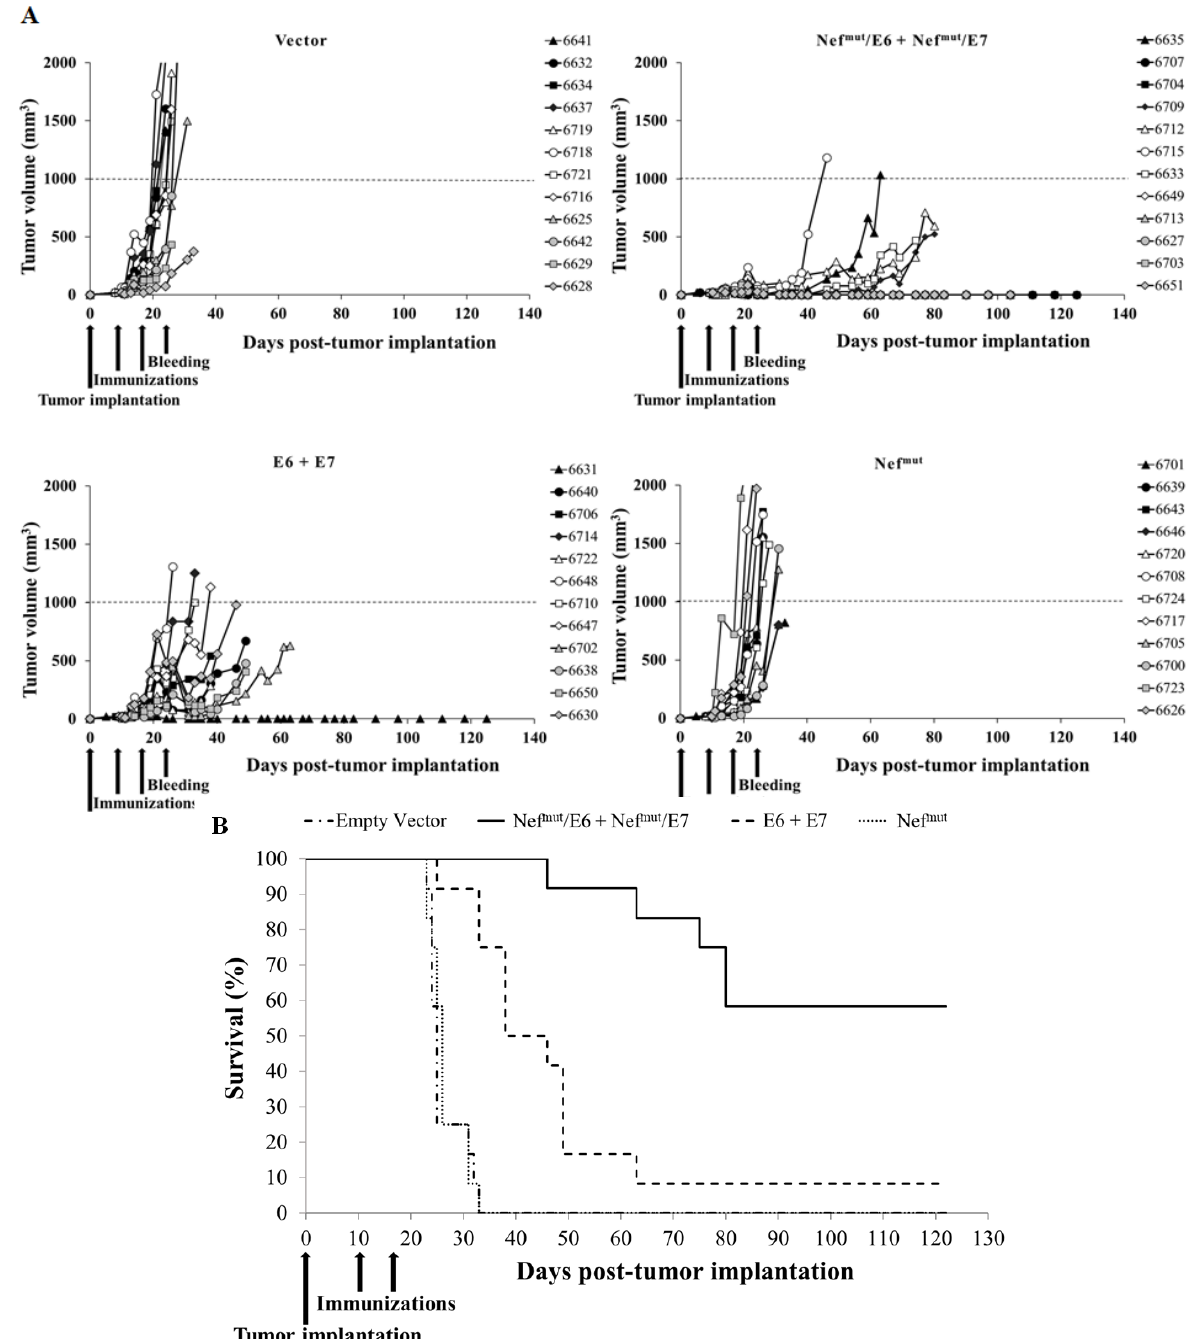
Figure 5. Antitumor therapeutic effect induced by i.m. injection of both Nef mut /E6 and Nef mut /E7 DNA vectors. ( A ) Tumor growth curves. C57 Bl/6 mice (12 per group) were challenged with 2 × 10 5 TC-1 cells and, in the presence of palpable tumor masses, co-inoculated with the indicated DNA vectors. The DNA inoculations were repeated at day 17 after tumor cell implantation, and the growth of tumor mass was followed over time. Shown are data referred to each injected mouse identified by the different symbols. Tumor sizes were measured every 2–3 days. X-axis scale indicates the days of tumor monitoring, as well as the timing of tumor implantation, immunization and bleeding. ( B ) Kaplan–Meier survival curve.